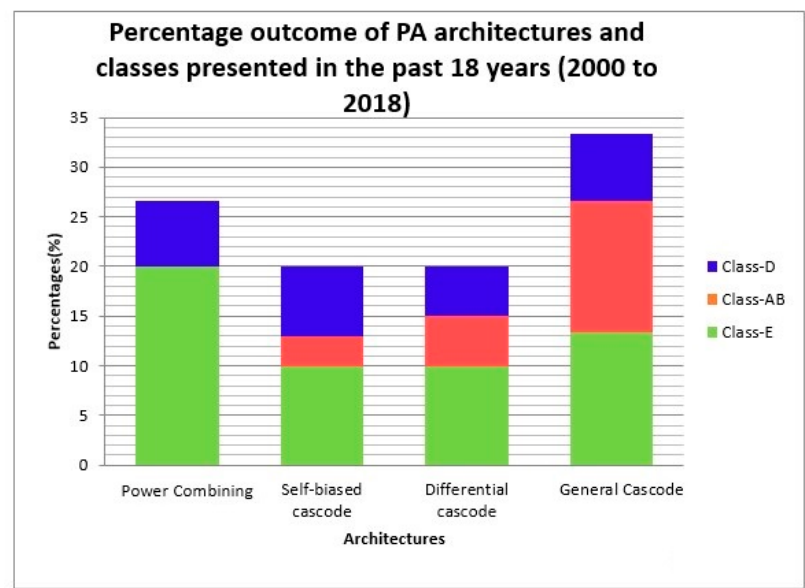
Figure 18. Bar graph of PA architectures and classes in the past 18 years (2000 to 2018).